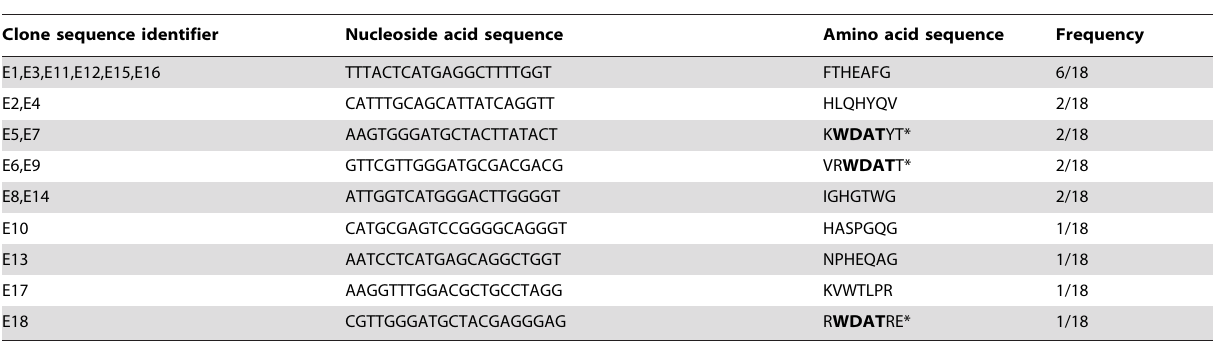
Table 1. Selected phage clones sequences from anti-CE pAbs.